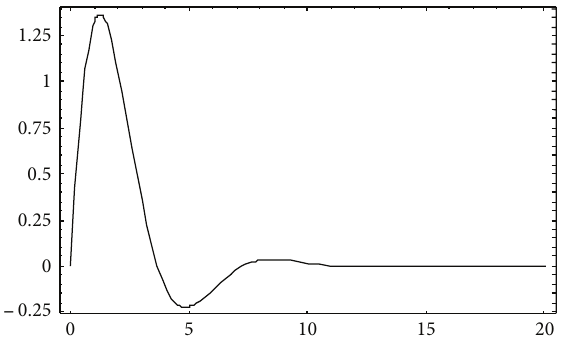
Figure 9: Time series analysis of e 1 ( f ).